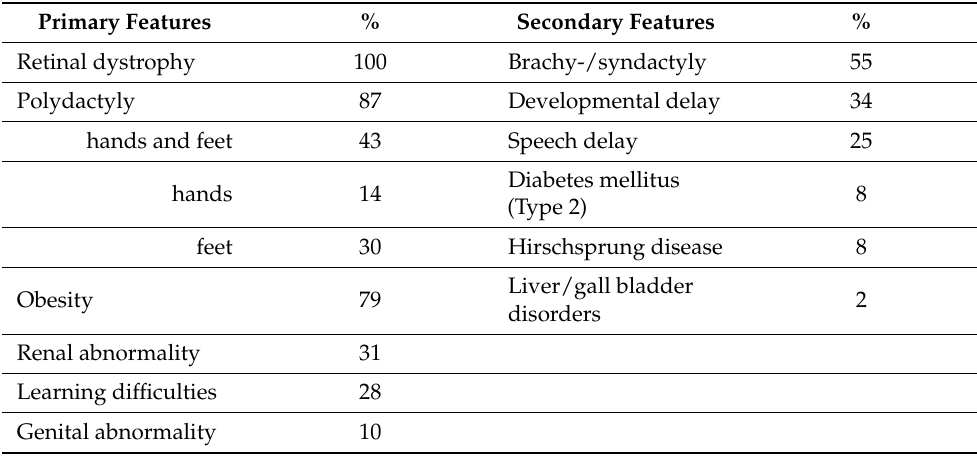
Table 2. Primary and secondary features of the BBS study